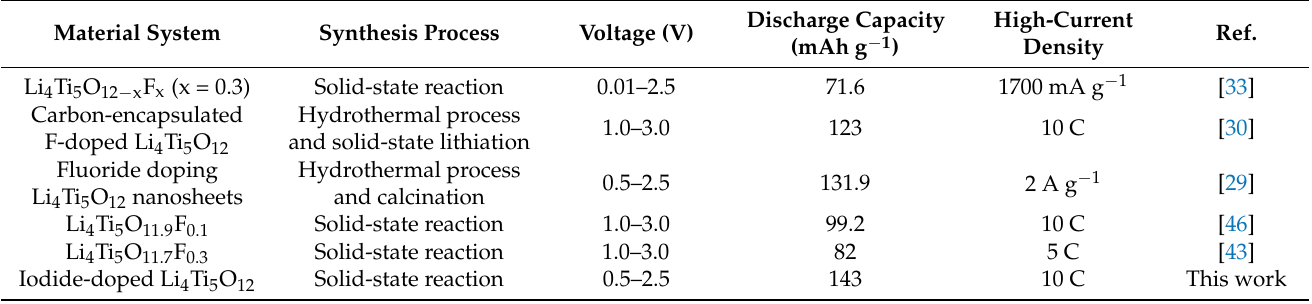
Table 2. Comparison of high-rate performance of the anion-doped LTO